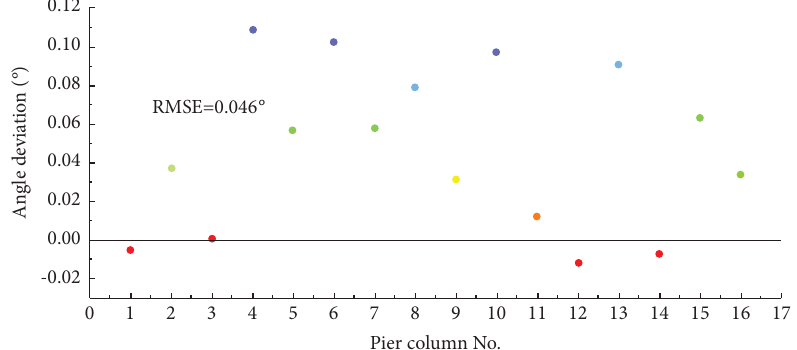
Figure 14: Deviation between the perpendicularity of the pier column and the design